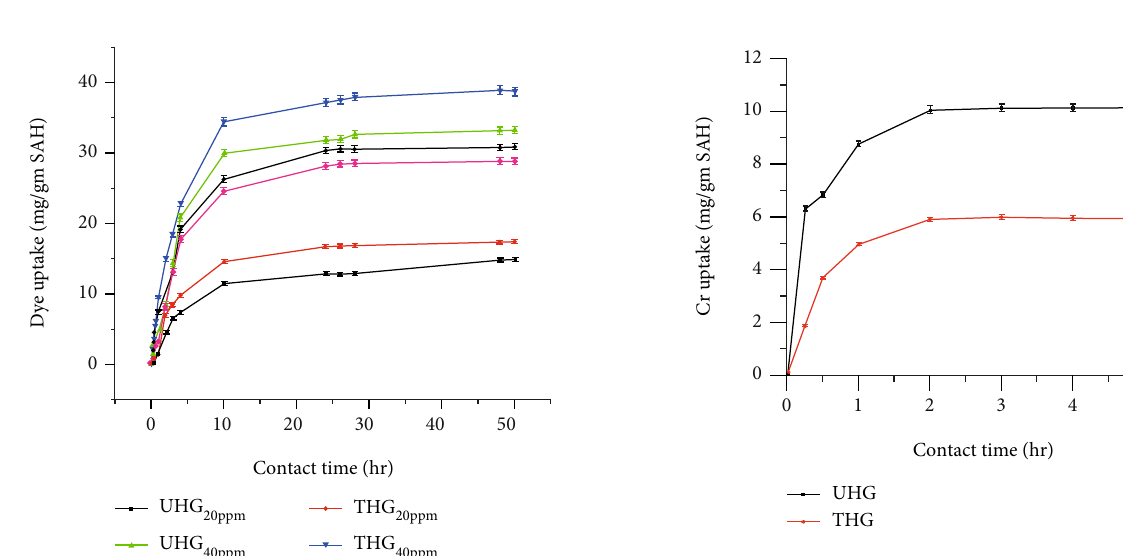
Figure 11: The e ff ect of contact time on the removal of chromium.